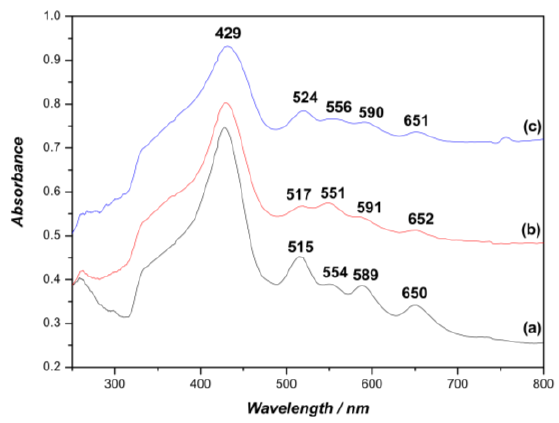
Figure 1. Solid state UV-Vis spectra of (a) P2-CF , (b) P3-CF and (c) P4-CF .